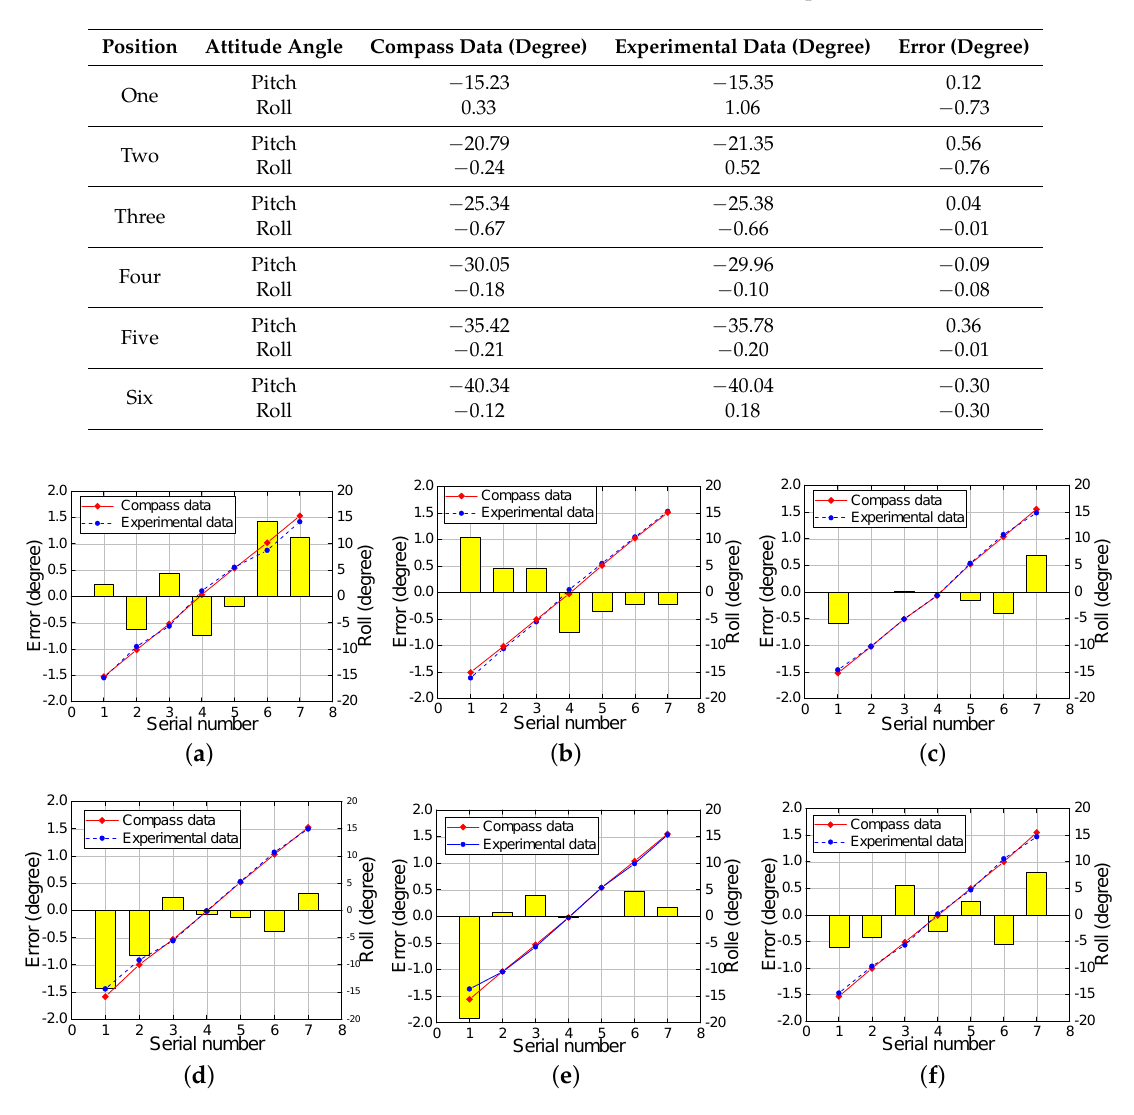
Table 5. Results of attitude determinations at six different positions.